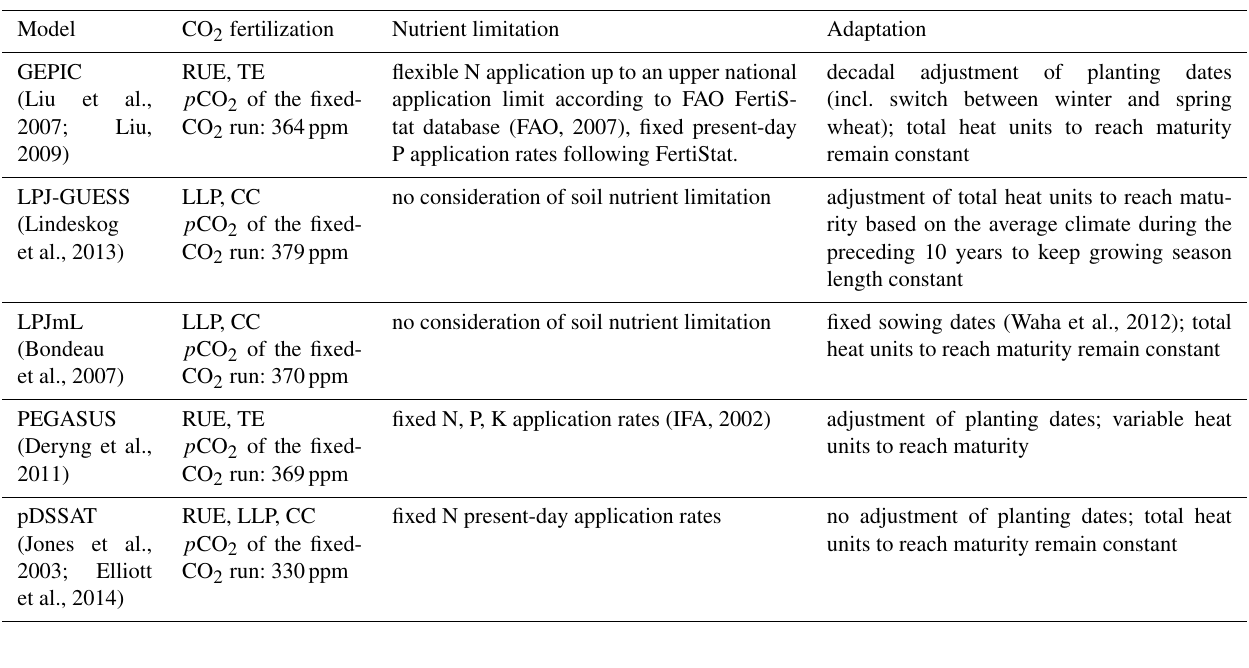
Table 1. Basic crop model characteristics with respect to (1) the implementation of CO 2 fertilization effect – as affecting radiation use efficiency (RUE), transpiration efficiency (TE), leaf-level photosynthesis (LLP), or canopy conductance (CC); (2) accounting for nutrient constraints and associated assumption with respect to fertilizer application (N: nitrogen; P: phosphorus; K: potassium); (3) implemented adaptation measures.